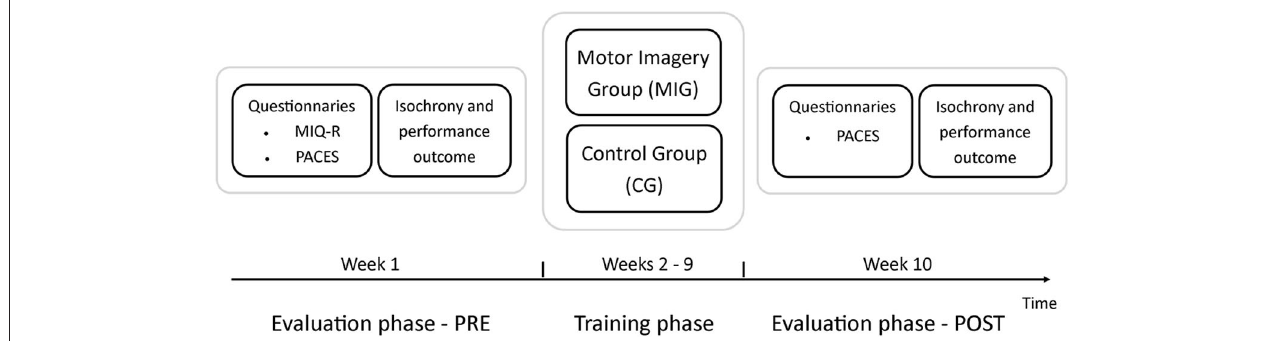
FIGURE 1 | Illustration of experimental design: During the first week of the experimentation (Week 1), the experimenter performed the evaluation phase (PRE). Questionnaire on motor imagery ability (MIQ-R) and enjoyment of physical education lesson (PACES) were administered. After that, participants performed the underhand serve (3 times) and imagined the same gesture. The isochrony between imagined and real movement and the number of ball that passed over the net (performance outcome) were computed. From Week 2 to Week 9, the two classes either performed the conventional training based on movement execution (Control Group) or added to the conventional training a motor imagery training (Motor Imagery Group). During Week 10, the experimenter replicated the same tests administered during week 1